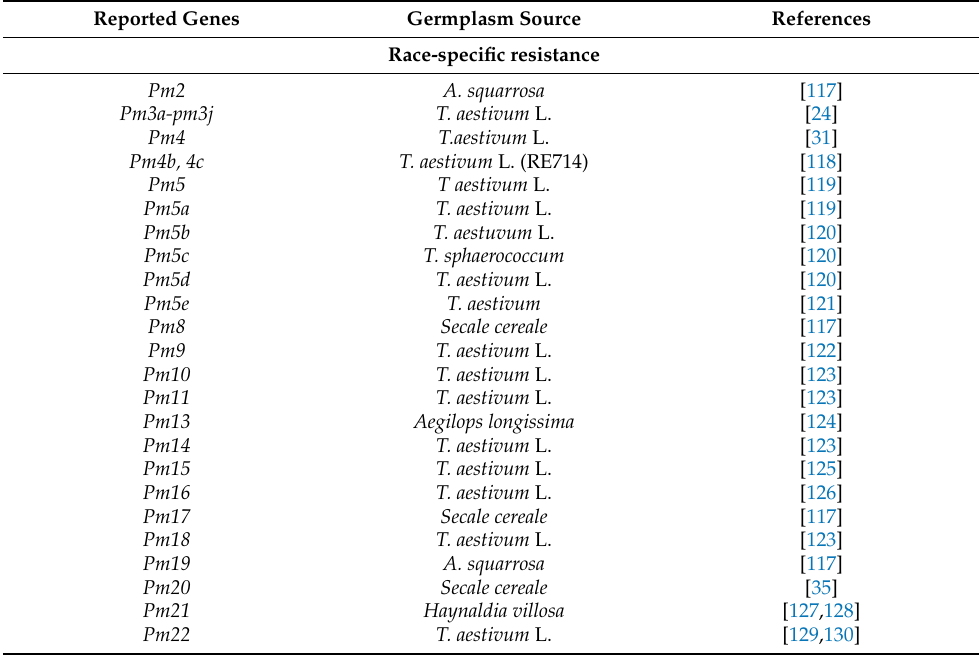
Table 1. Genes associated with powdery mildew race-specific and race-non-specific resistance, germplasm source, and their